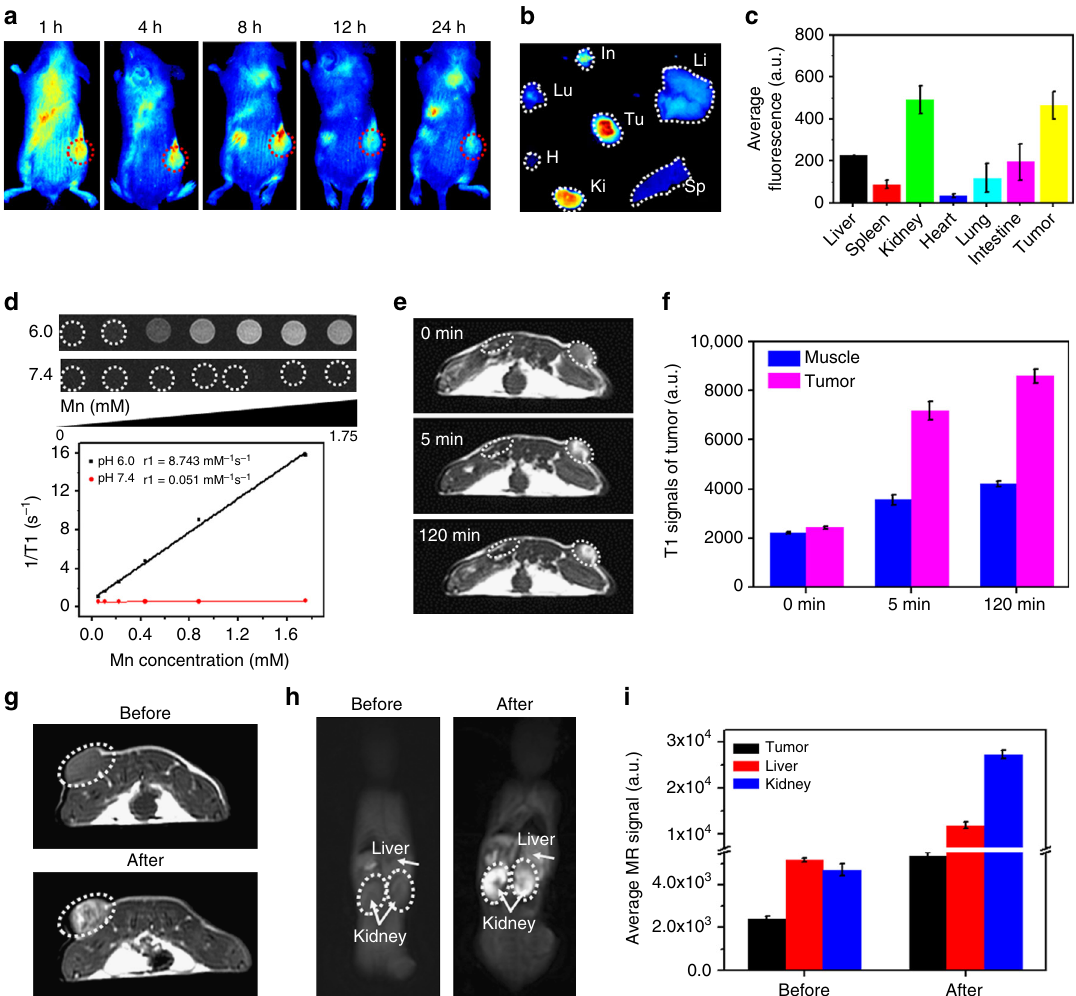
Fig. 4 In vivo and ex vivo imaging with H-MnO 2 -PEG/C&D. a In vivo fl uorescence images of 4T1 tumor-bearing mice taken at different time points post i.v. injection of H-MnO 2 -PEG/C&D (three mice per group). b Ex vivo fl uorescence images of major organs and tumor dissected from mice at 24 h p.i. Sp, Ki, H, Lu, In, Li, and Tu stood for spleen, kidney, heart, lung, intestine, liver, and tumor, respectively. c Semi-quantitative analysis of ex vivo fl uorescence images in different organs in ( b ). d T1-weighted MR images of the H-MnO 2 -PEG/C&D recorded using 3T MR scanner at different pH values (6 and 7.4). The transverse relativities (r1) were 8.743 and 0.051 mM − 1 s − 1 for H-MnO 2 -PEG/C&D at pH 6 and 7.4, respectively. e T1-MR images of 4T1 tumor-bearing mice before and after local injection of H-MnO 2 -PEG/C&D within normal and tumor subcutaneous tissues (three mice per group). f Quanti fi ed T1-MR signals in muscle and tumor before and after injection of H-MnO 2 -PEG/C&D based on images in ( e ). g , h In vivo T1-MR images of a mouse taken before and 24 h post i.v. injection of H-MnO 2 -PEG/C&D shown in cross section ( g ) and longitudinal section ( h ). i Quanti fi cation analysis of T1-MR signals in liver, kidney, and tumor, before and 24 h post i.v. injection or H-MnO 2 -PEG/C&D nanoparticles. Date are presented as means ± s.d. ( n = 3 mice per